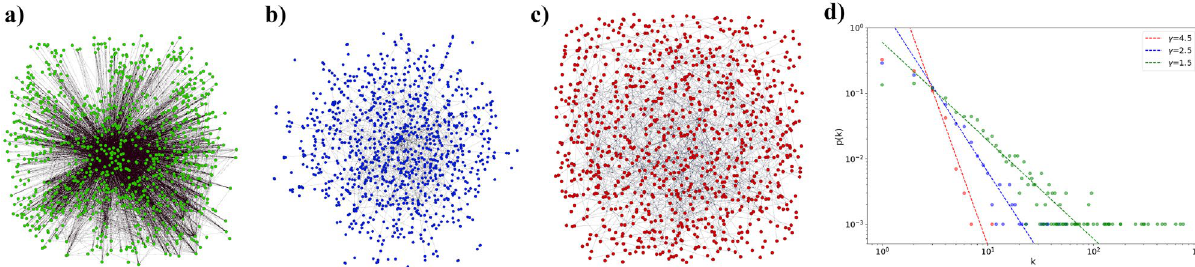
1.5 , ( b ) γ 2.5 and ( c ) γ 4.5 , which = = = 1000 =